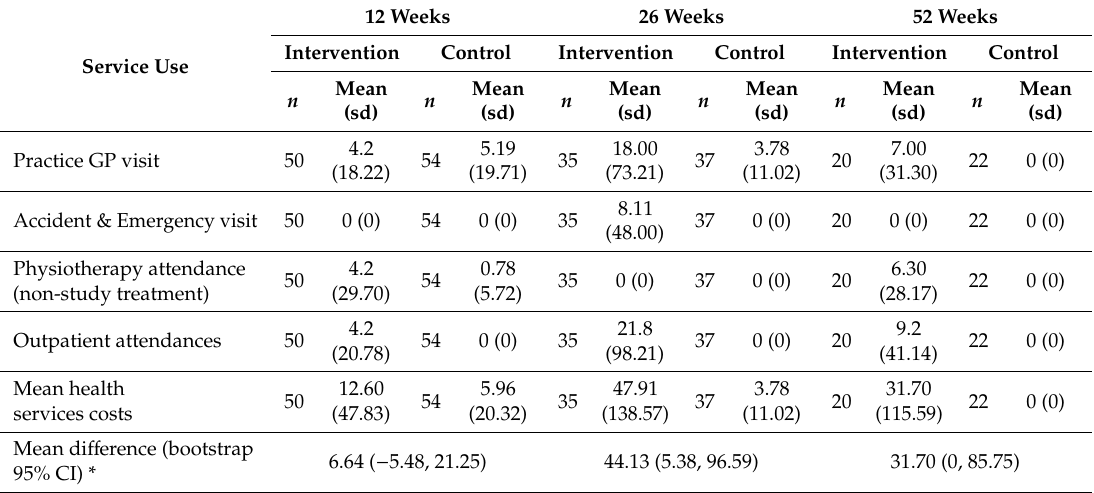
Table 6. Cost (£) of health service use over the study period by group. Values are means (standard deviations) unless otherwise stated.